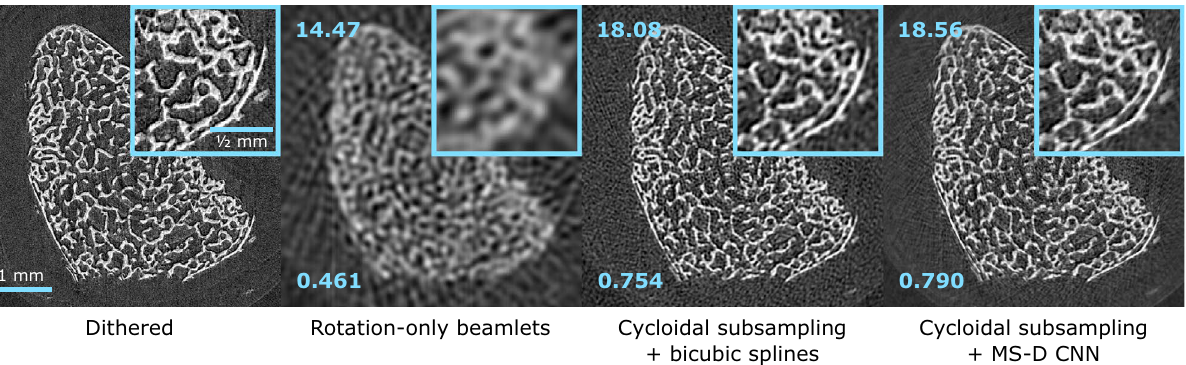
Figure 8. Tomographic images of a chicken bone (attenuation contrast; step-and-shoot acquisition). From left to right: image reconstructed from a complete (i.e. dithered) sinogram, an incomplete rotation-only beamlet sinogram interpolated with bicubic splines, an incomplete cycloidal sinogram interpolated with bicubic splines, an incomplete cycloidal sinogram processed with the MS-D CNN. The PSNR (top left) and MS-SSIM (bottom left) with respect to the dithered image are shown for each low-dose